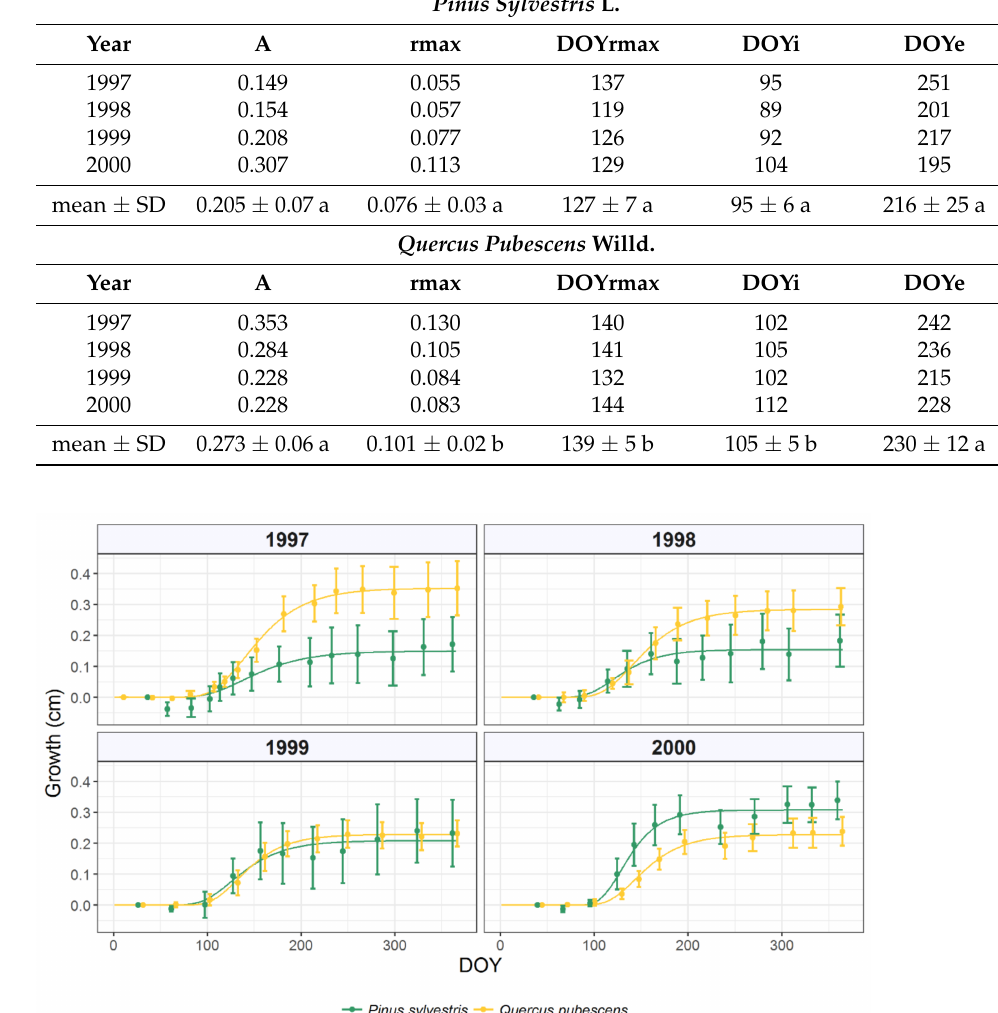
Table 1. Parameters of the Gompertz function fitted to cumulative radial growth increments per species and year. Different lowercase letters represent interspecific significant differences ( p < 0.05). A, uppermost asymptote or maximum radial increment; rmax, maximum growth rate; DOYrmax, day of the year that the maximum growth rate occurs; DOYi, day of the year that occurs the 5% of A; DOYe; day of the year that occurs the 95% of A. Pinus Sylvestris L.